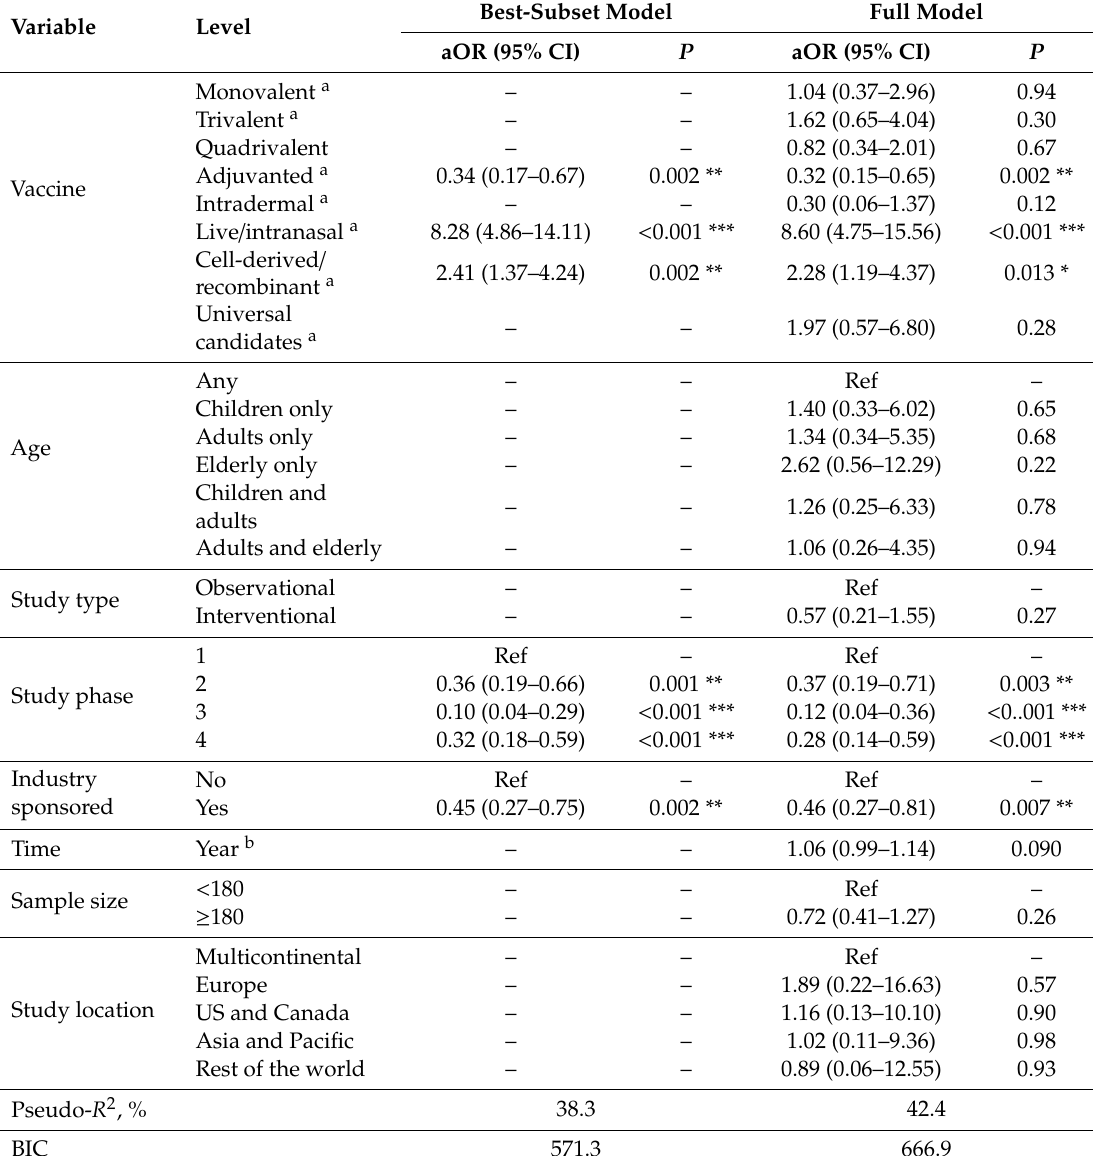
Table 3. Multivariable logistic regression models to predict the use of enzyme-linked immunosorbent assay